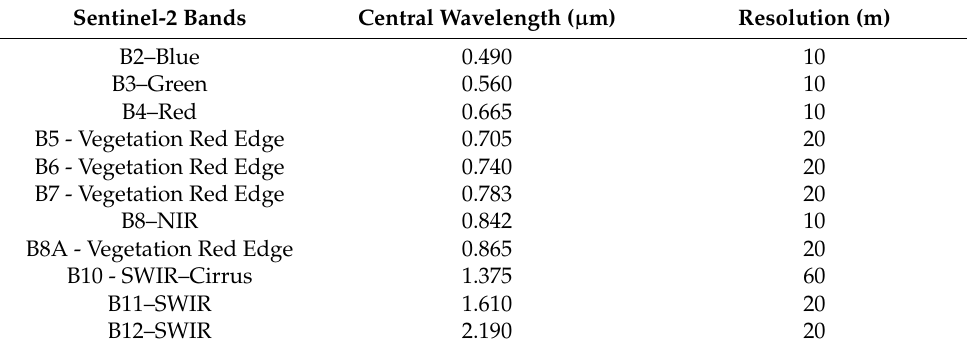
Table 2. Sentinel-2 spectral bands.